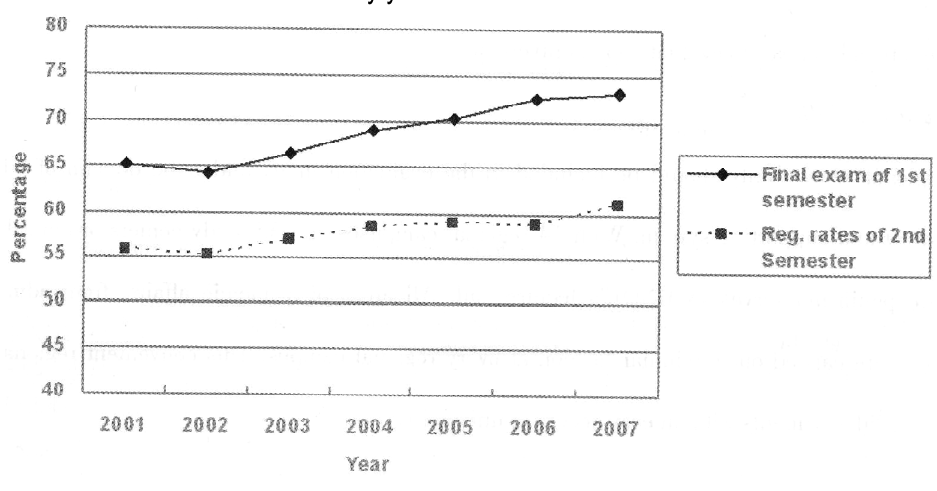
Figure 3. The Rend acv of applying ate of final examination (1 st semester) and registration rates of 2 nd semester by